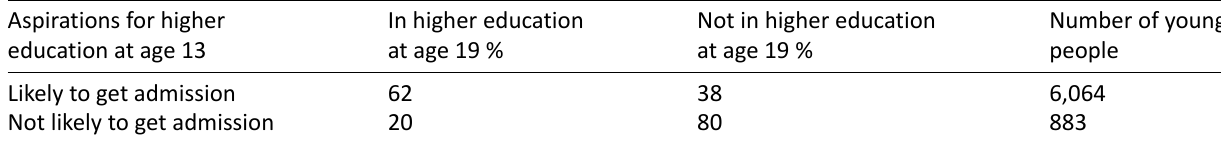
Table 7. Link between higher education aspirations at age 13 and higher education admission outcome at age 19. Aspirations for higher